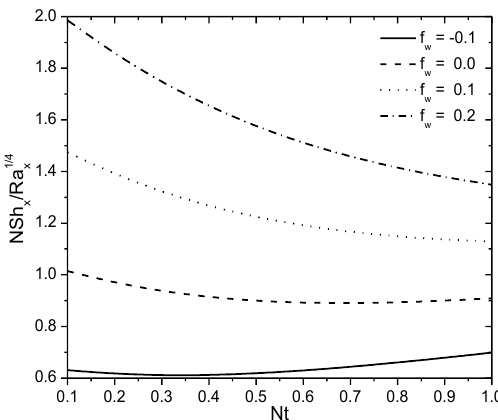
Sherwood number